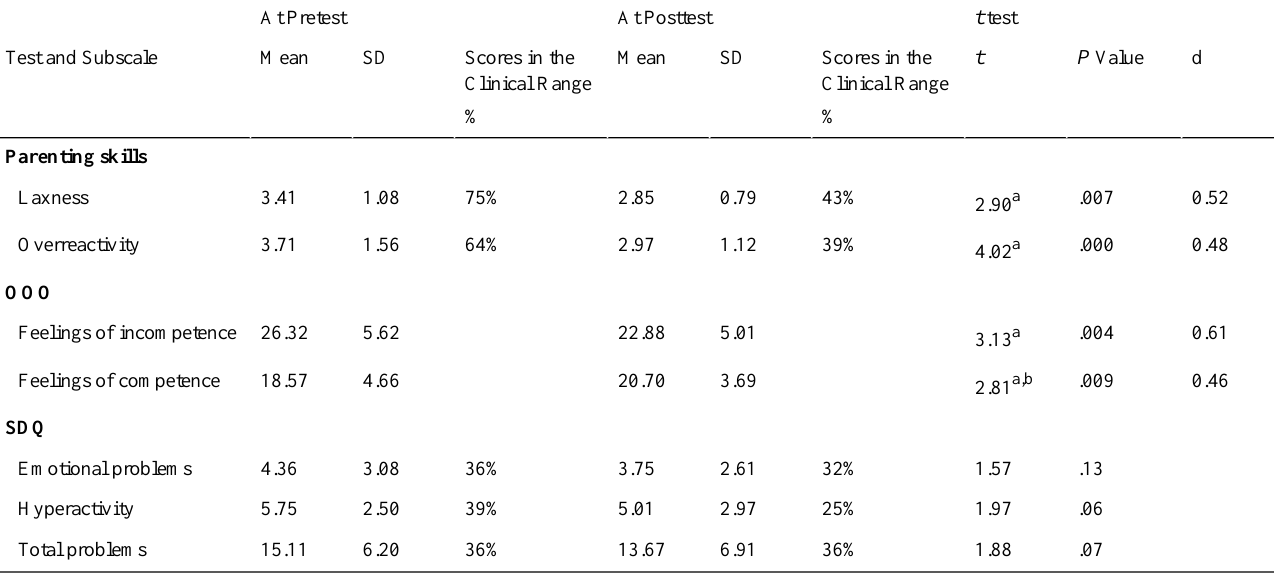
Table 1. Short-term intervention effects on parenting skills, sense of parenting competence as measured by Ouderlijke Opvattingen over Opvoeding (parental beliefs about parenting-questionnaire) and child well-being as measured by the Strengths and Difficulties Questionnaire (n =